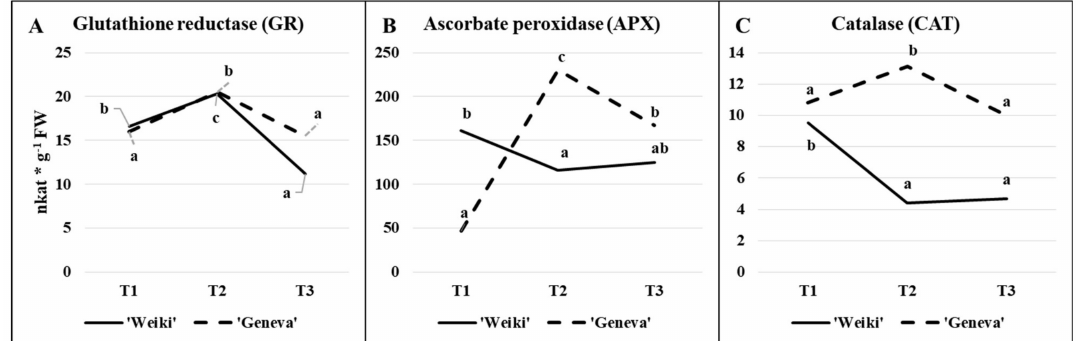
Figure 3. Antioxidative enzyme activity (nkat g − 1 FW) of: ( A ) glutathione reductase, ( B ) ascorbate peroxidase, ( C ) catalase; depending on the time of sampling in leaves of two A. arguta cultivars in 2015. Presented data are means for three soil N levels and three replications. Values marked with a different letter in each group differ significantly at p ≤ 0.05 (Tukey HSD test). Cultivars were analysed separately; T1—(28.05.15) the stage of fully developed leaves, T2—(16.07.15) the peak of the most intensive fruit growth and T3—(27.08.15) the beginning of fruit physiological